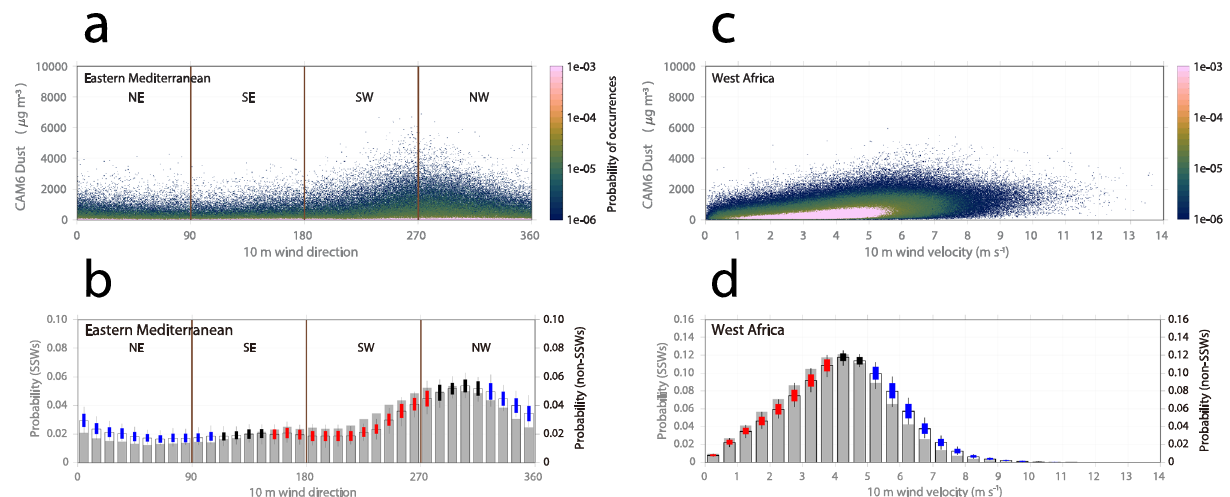
1000 sets of non-SSW episodes, black un fi lled bars show the mean and black whiskers show the spread. The boxes ( fi lled in black, red, and blue colors) indicate the5thand95thpercentiles.Theboxesare fi lledinredandbluewhenSSW-caused increases and decreases are statistically signi fi cant at the p <0.10 level based on a two-tailedMonteCarlotest,respectively. c , d Thesameas a , b butforsurfacewind velocities (from the MERRA2 reanalysis) at all grid points within West Africa. To generate the bivariate histogram plots, we partition the surface dust concentra- tionsinto500binsofwidth20 μ gm − 3 within[0,10,000],thesurfacewinddirection into 720 bins of width 0.5° within [0,360], and the surface wind velocity into 700 bins of width 0.02ms − 1 within [0,14],